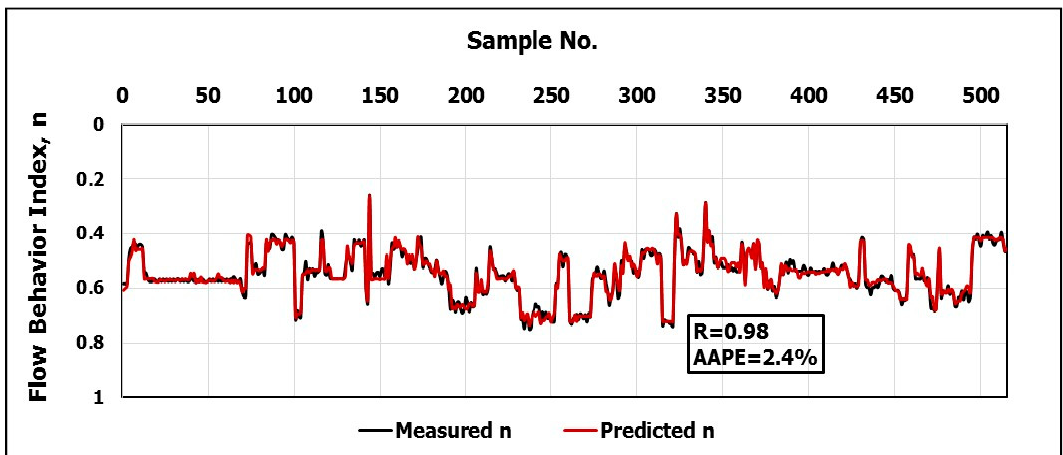
Figure 6. Measured n vs. Predicted n from the ANN model . Table 7. The optimized coefficients for estimating the normalized 𝑛 (cid:3041) in Equation (24).